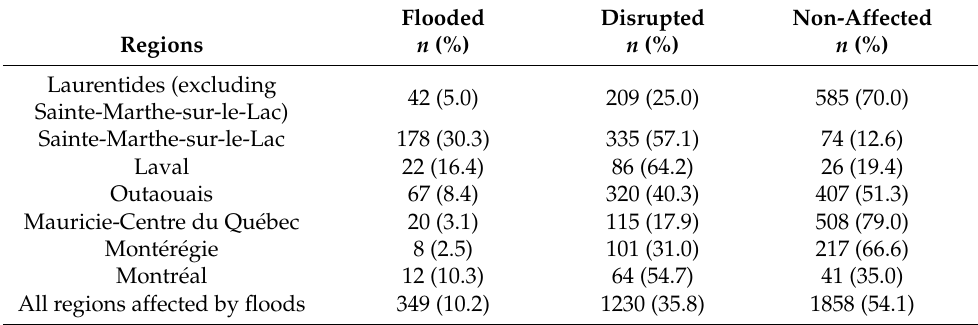
Table 1. Flood exposure according to regions.